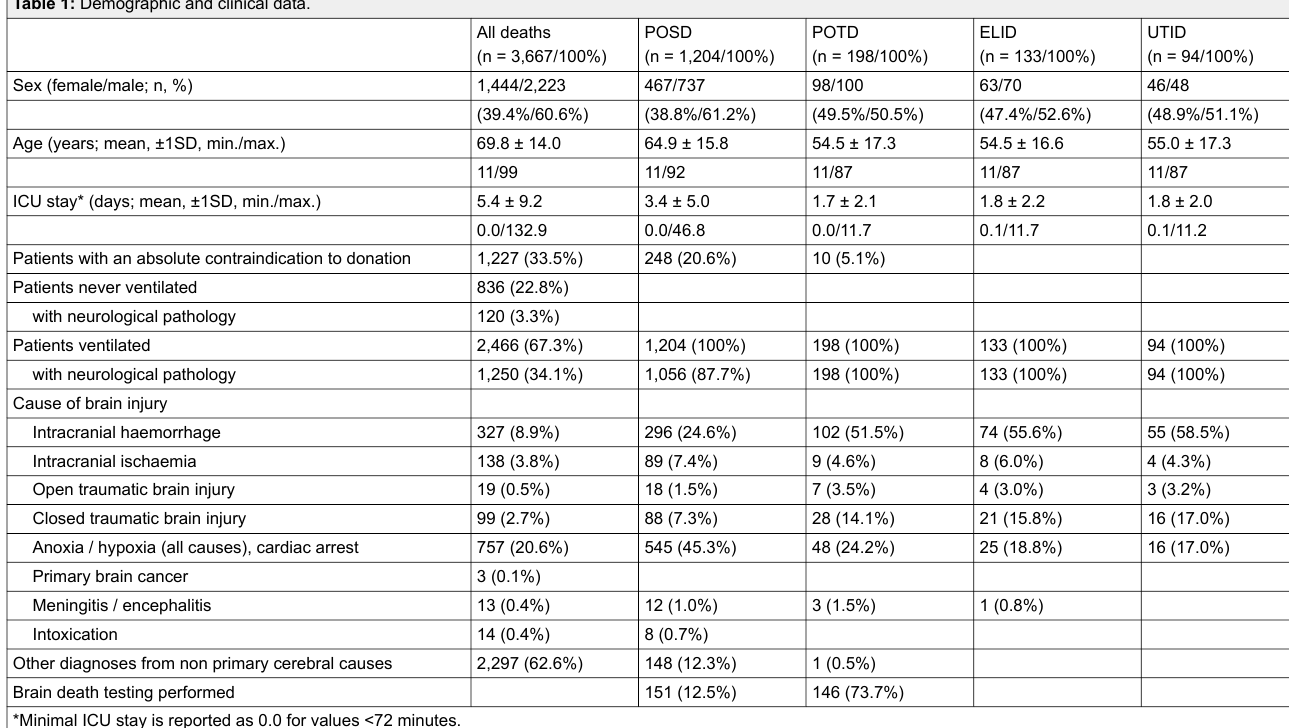
Table 1: Demographic and clinical data.